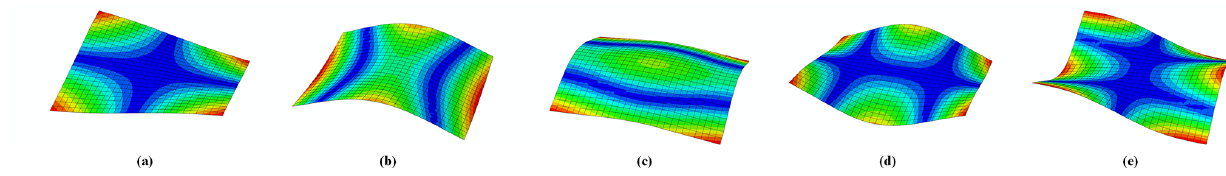
Figure 12. Simulation results of the first five modes of the honeycomb sandwich panel.